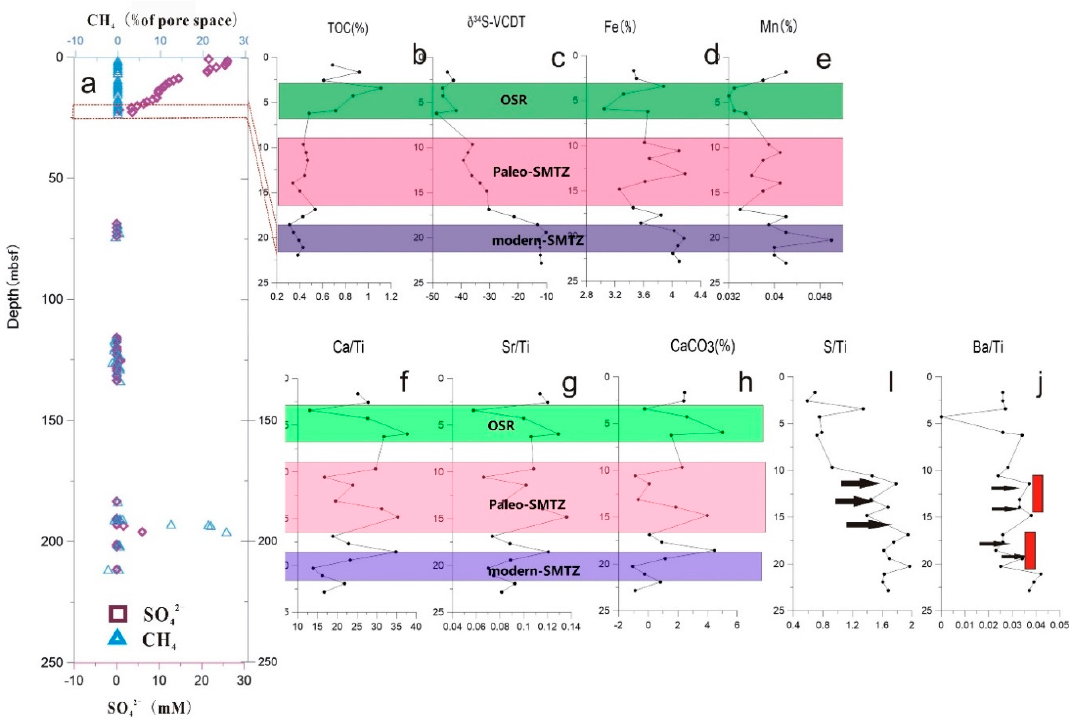
Figure 2. In the picture, the green represents OSR, the red represents paleo-SMTZ and purple represents modern- SMTZ. ( a ) shows the concentration of sulfate and methane in the pore water as a function of depth; ( b ) Total organic carbon content varies with depth; ( c ) δ 34S value in sediment changes with depth; ( d – h ) Ratios of the main elements Fe, Mn and Ca / Ti, Sr / Ti, S / Ti, Ba / Ti, trends with depth. ( i , j ): Black arrows in the Ba / Ti and S / Ti ratios indicate the peaks that were spaced apart: when the S / Ti peak immediately followed the Ba / Ti peak it generally indicated the modern SMTZ interface. Red indicates the concentration of sulfate and methane in the pore water as a function of depth, which shows that the modern SMTZ tended to move vertically.